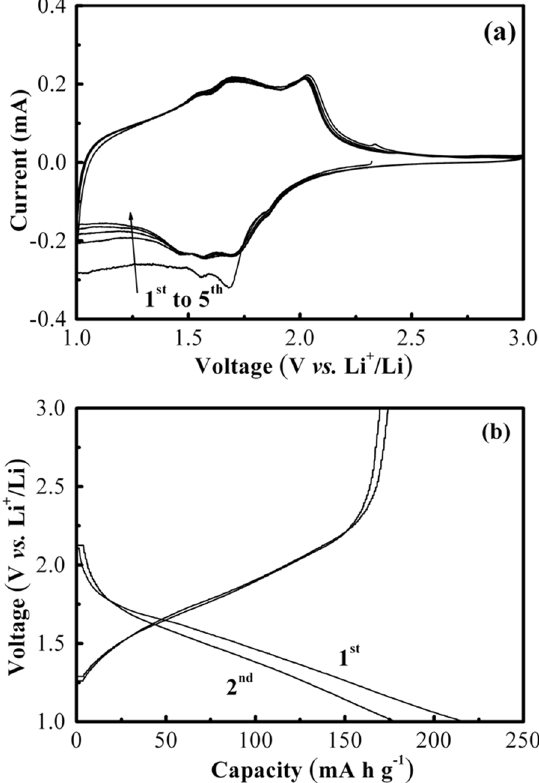
Figure 5. The electrochemical properties of TiO 2 @Nb 2 O 5 composites: ( a ) CV curves with a scan rate of 0.5 mV s − 1 and ( b ) charge-discharge profiles at a current density of 1 A g − 1